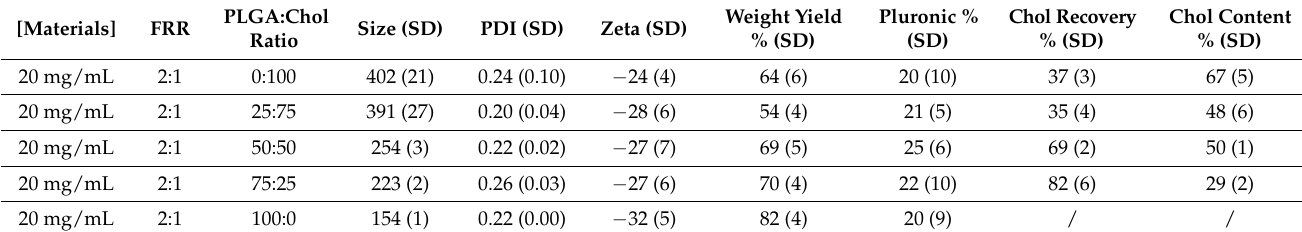
Table 4. Physico-chemical characterization of H-NMeds obtained with the microfluidic device varying the ratio between PLGA and Cholesterol. Standard Deviation (SD) is reported in